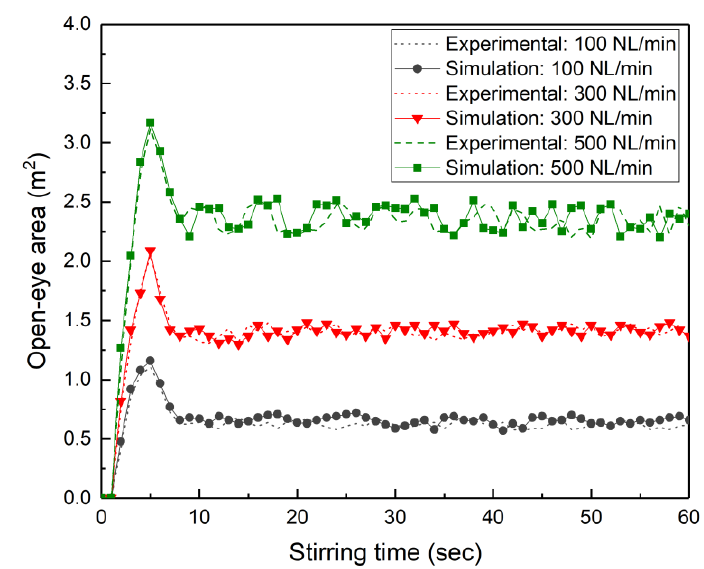
Figure 4. Comparison between experimental and simulation results of time-averaged open-eye area.